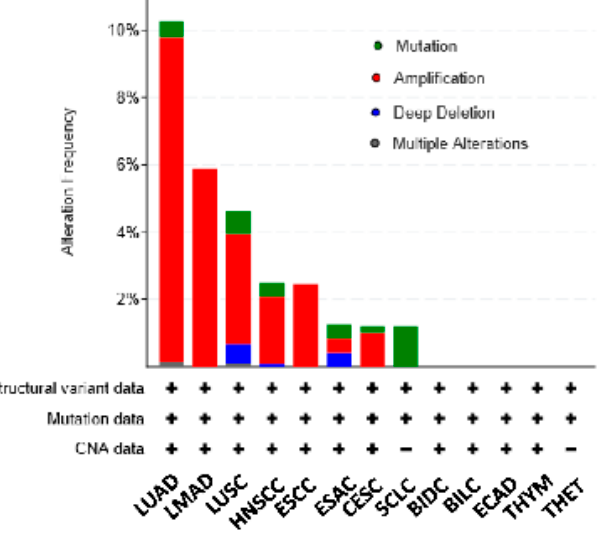
Figure 3. Genetic alterations of the PAX9 DNA in human cancers that differentially express PAX9